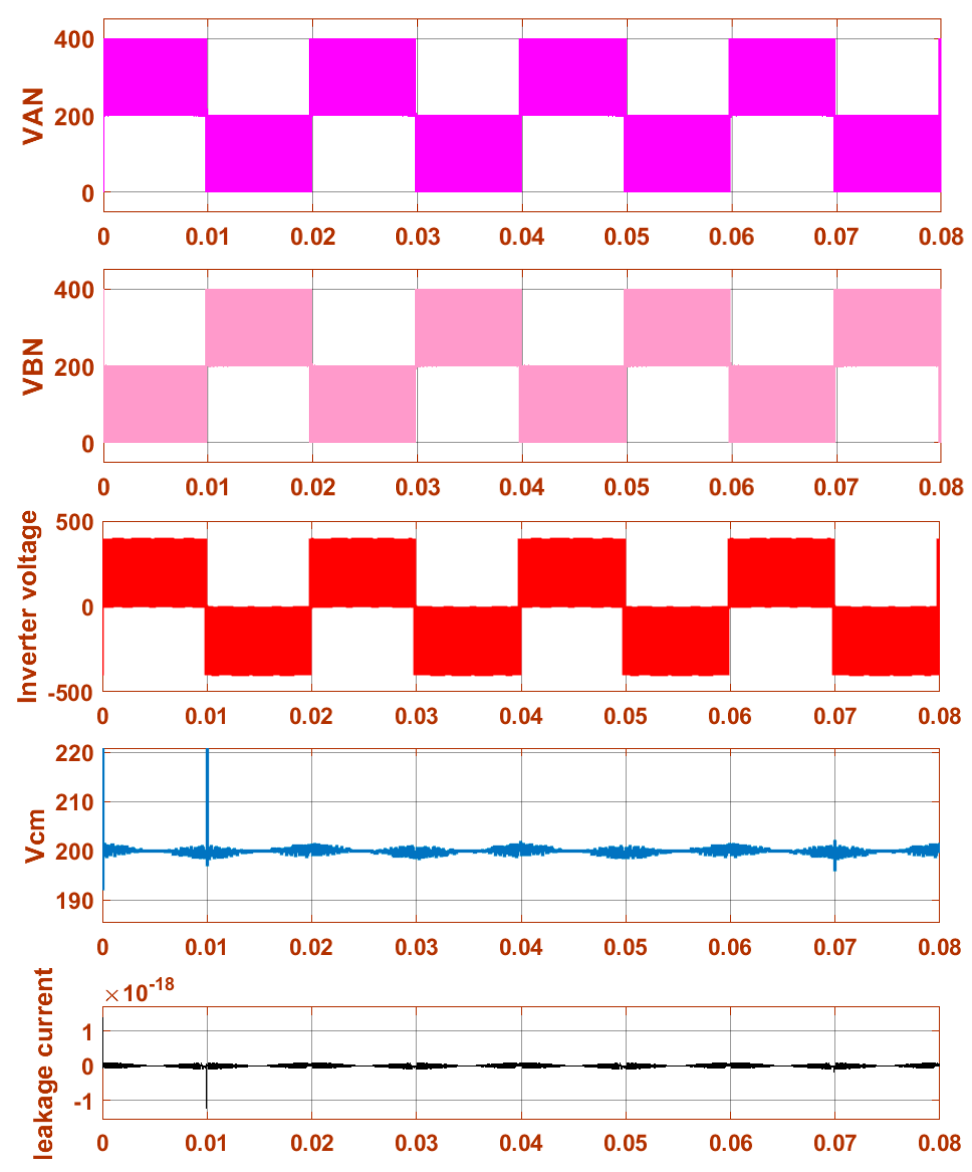
Figure 17. Waveform of V AN , V BN , inverter voltage and V cm , leakage current of proposed novel H6 inverter.